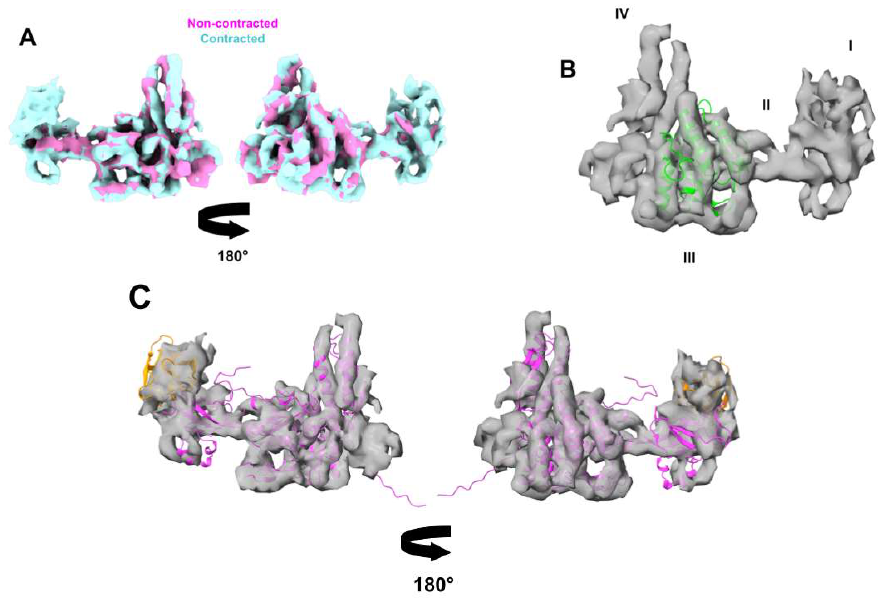
Figure 7. Phage G tail sheath subunit structure. ( A ) The phage G tail sheath subunit from the non- contracted (pink) and contracted (cyan) structures were superimposed using ChimeraX fit-to-model feature [34]. The densities superimposed almost completely, except for the outer domain region, where the non-contracted structure (pink) has poorly defined density. ( B ) The phage G sheath protein structure has several alpha helices as shown by the rodlike density of the contracted tail sheath subunit (transparent grey). The phage G sheath structure also follows the same domain organization described for T4 [6,33]. The green alpha helices were fitted from the T4 tail sheath crystal structure residues 21–201 (PDB: 3FOA) [6]. ( C ) Alphaflold2 [32] was used to generate a model prediction of the phage G sheath protein and the two regions (magenta and orange) were fitted independently into the contracted phage G sheath subunit density. The magenta area (residues 1–119 and 219–579) represents the innermost domain regions, and the outermost domain is in orange (residues 120–218). The first 26 and last 17 amino acids were predicted to be disordered.